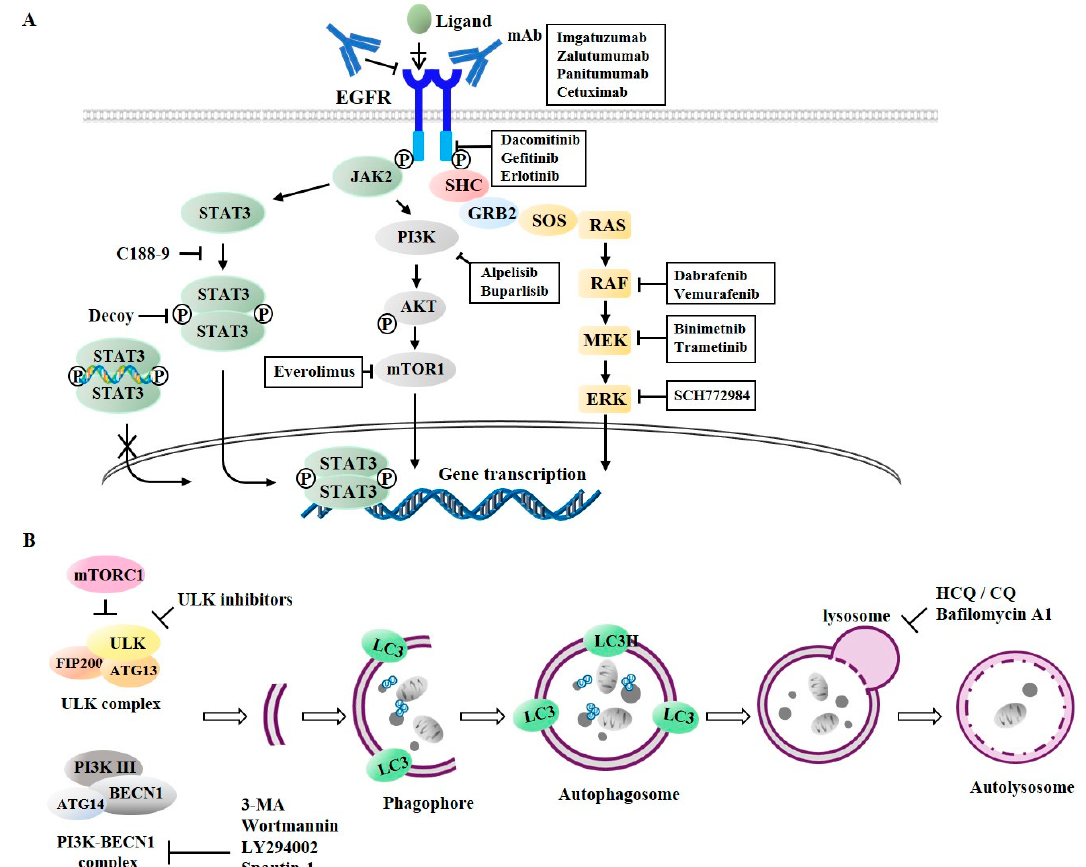
Figure 6. Anti-cancer drugs targeting EGFR signaling and autophagy. ( A ) Anti-EGFR monoclonal antibodies (mAbs) targeting EGFR include cetuximab, panitumumab, zalutumumab, and imgatuzumab. These mAbs bind to extracellular domain of EGFR and inhibit binding of ligands to EGFR. EGFR-TKI such as erlotinib targets intracellular tyrosine kinase domain to inhibit autophosphorylation of EGFR. Buparlisib and Alpelisib target PI3 Kinase. Everolimus targets mTOR activity and PI3K signaling. SCH772984 targets ERK activity. ( B ) Wortmannin, 3-methyladenine (3-MA), and LY294002 inhibit VPS34 complex formation. Spautin-1 promotes its degradation. Hydroxychloroquine (HQ),